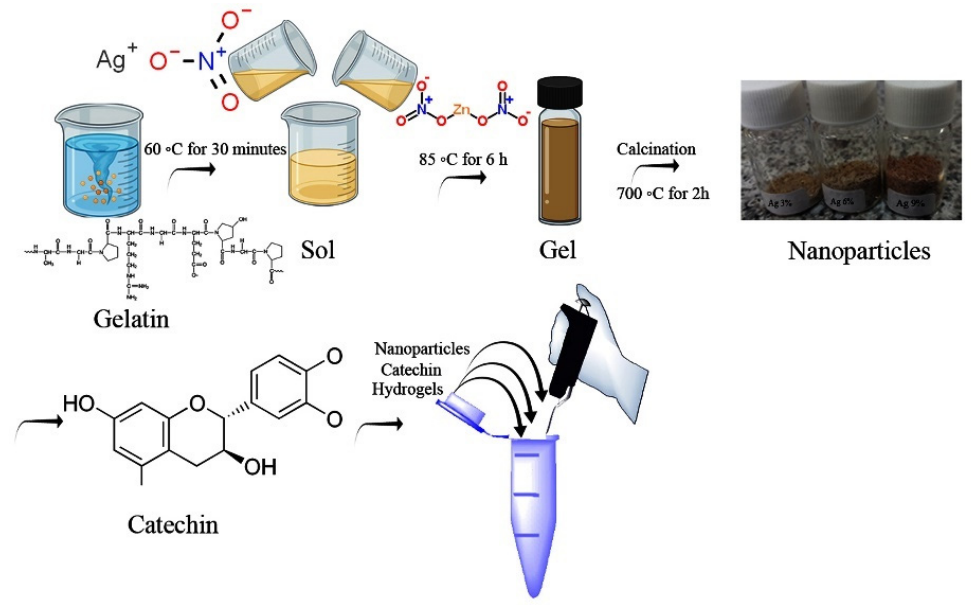
Figure 1. Schematic diagram of nanoparticles’ synthesis.